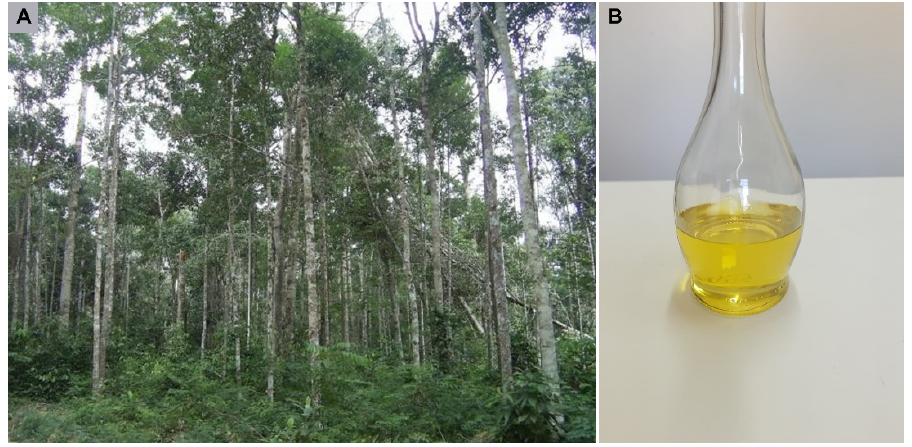
Figure 1. Aniba rosaeodora tree ( A ) and essential oil ( B ).